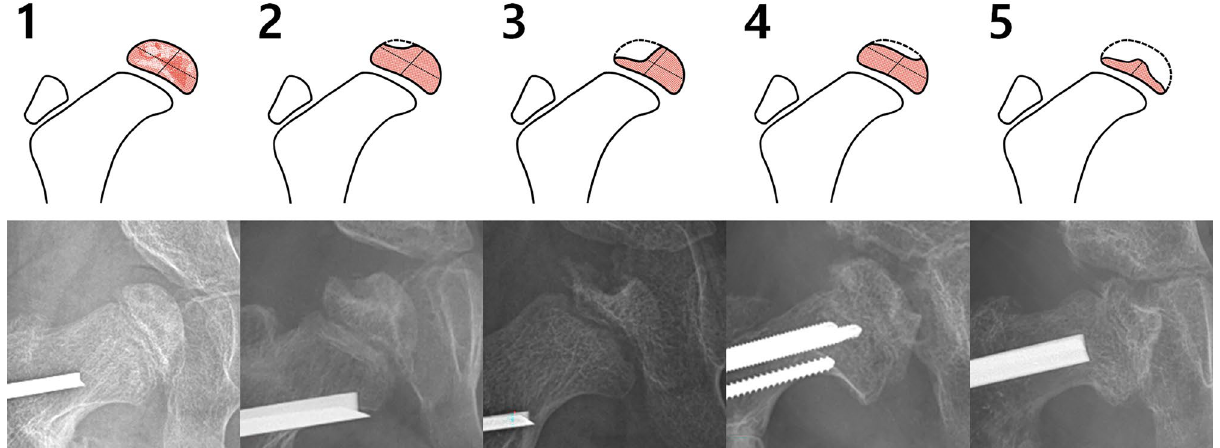
Figure 1. Five-type classification of avascular necrosis of the femoral head (AVN) based on the severity and location. Severity was defined as mild if height was preserved, moderate if more than 50% of height was retained, and severe if less than 50% of epiphyseal height remained. Types 2 and 3 AVN were confined to the lateral epiphysis, and Types 1, 4, and 5 involved the entire